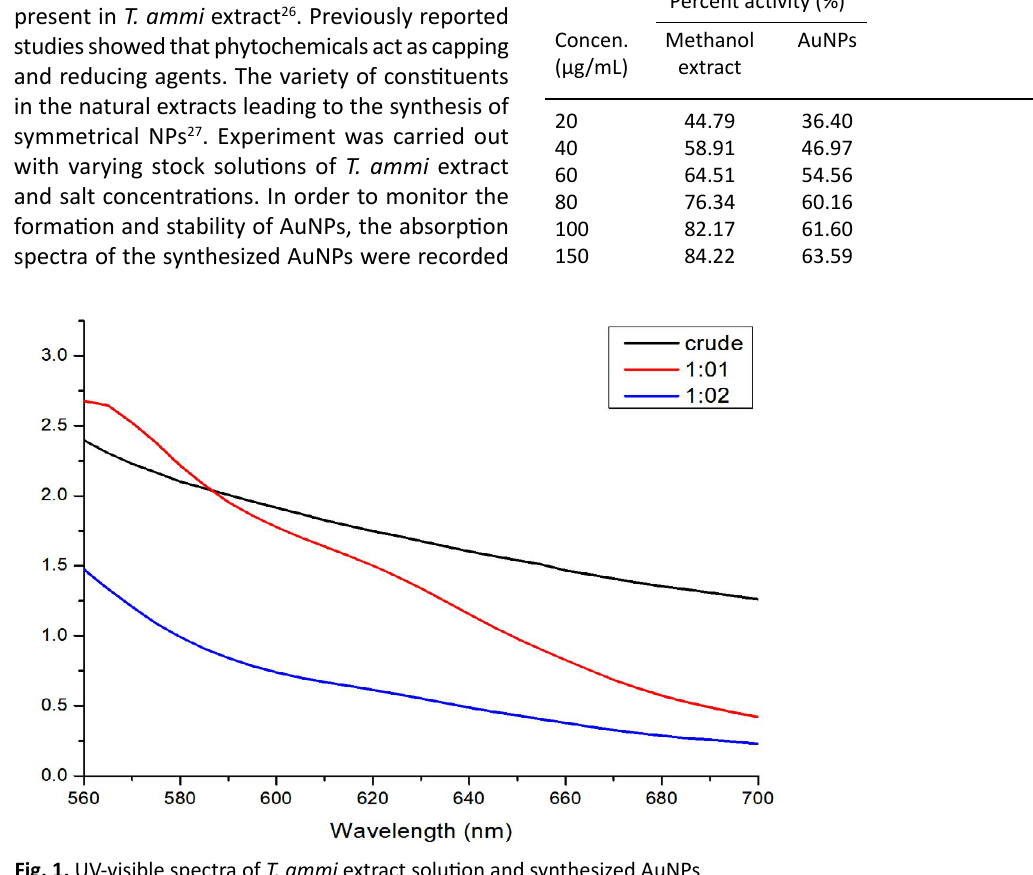
Table 2. DPPH• free radical scavenging activities of T. ammi crude extract and AuNPs Percent activity (%) Concen.